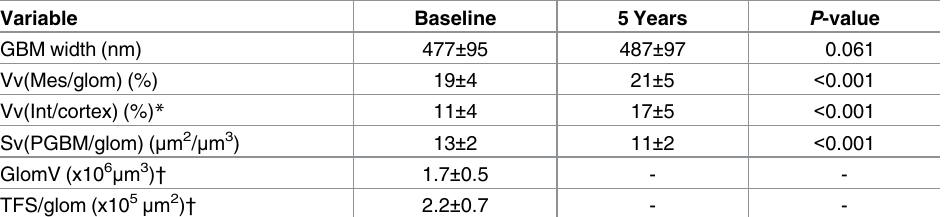
Data are means ± SD. P -values are for changes in morphometric measurements over 5 years. Abbreviations used: GBM, glomerular basement membrane; Sv(PGBM/glom), surface density of the peripheral glomerular basement membrane; Vv(Int/cortex), interstitial cortical fractional volume; Vv(Mes/glom), mesangial fractional volume per glomerulus; GlomV, mean glomerular volume; TFS/glom, total filtration surface per